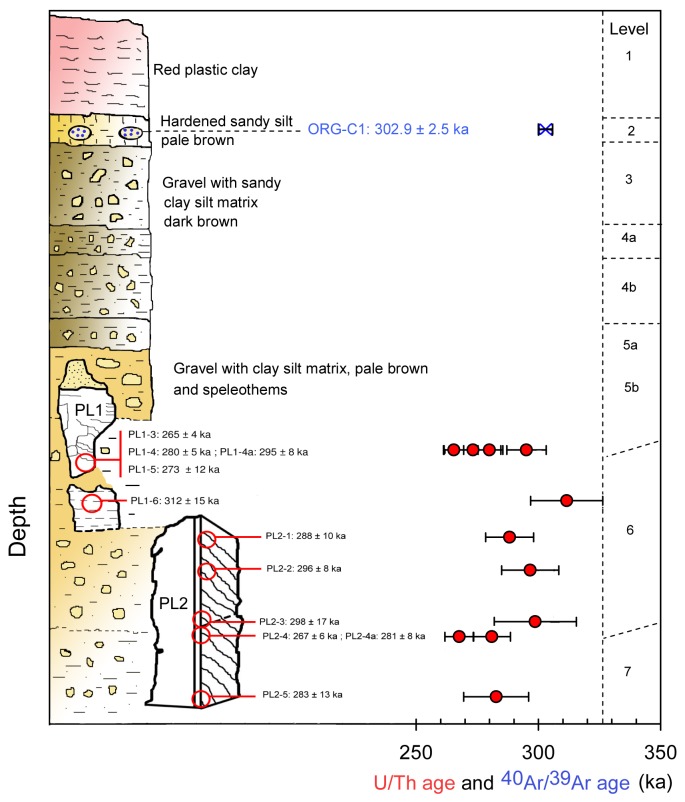
Stratigraphic positions of speleothem samples and volcanic minerals at Orgnac 3 with corresponding U/Th and 40Ar/39Ar dates.